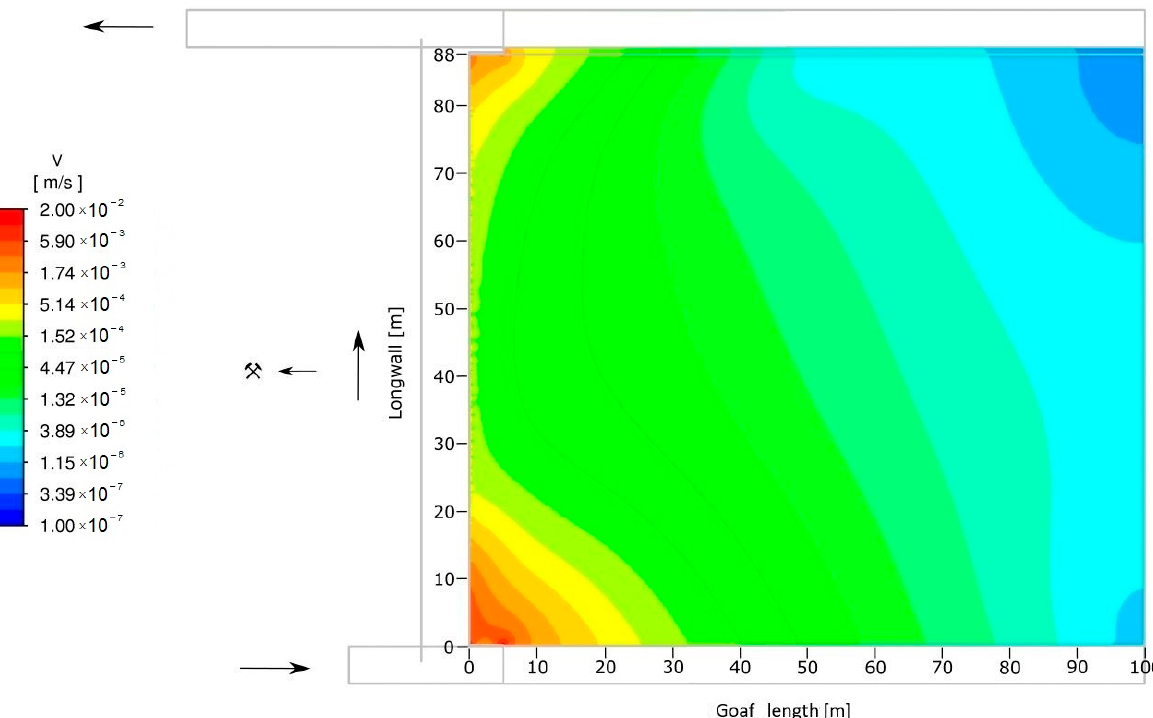
Figure 9. Velocity contours on a logarithmic scale in the range from 1.0 × 10 − 7 m/s to 0.02 m/s for a model with constant parameters of porosity and permeability in the goaf.